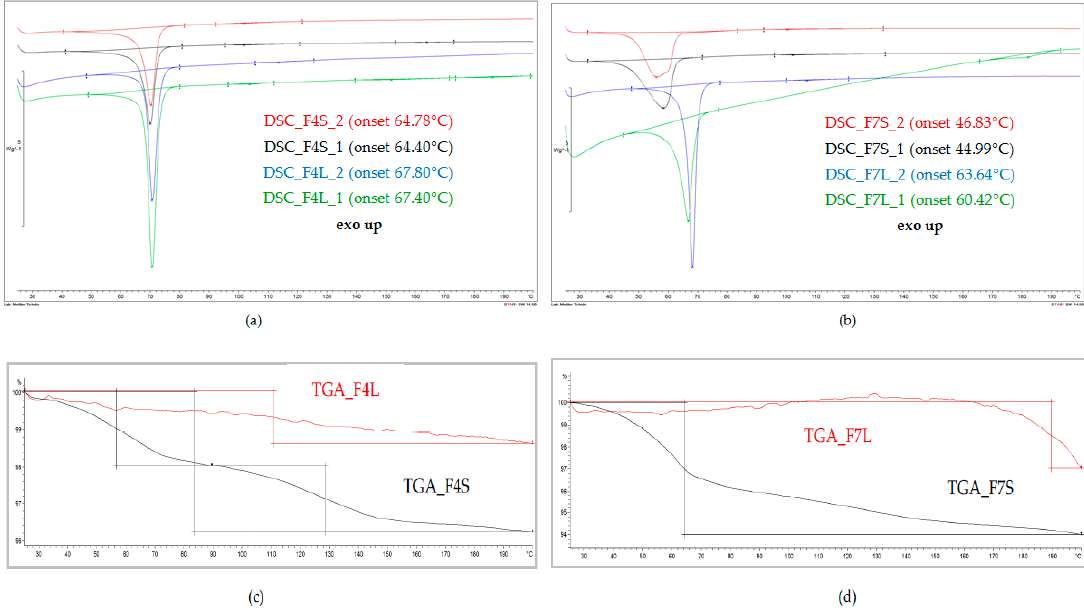
Figure 4. Thermal analysis of the API-loaded SLM prepared “de novo” (FL) and after spray drying (FS): ( a ) and ( b ) are differential scanning calorimetry (DSC) and ( c ) and ( d ) are thermogravimetry. (FS): ( a ) and ( b ) are di ff erential scanning calorimetry (DSC) and ( c ) and ( d ) are